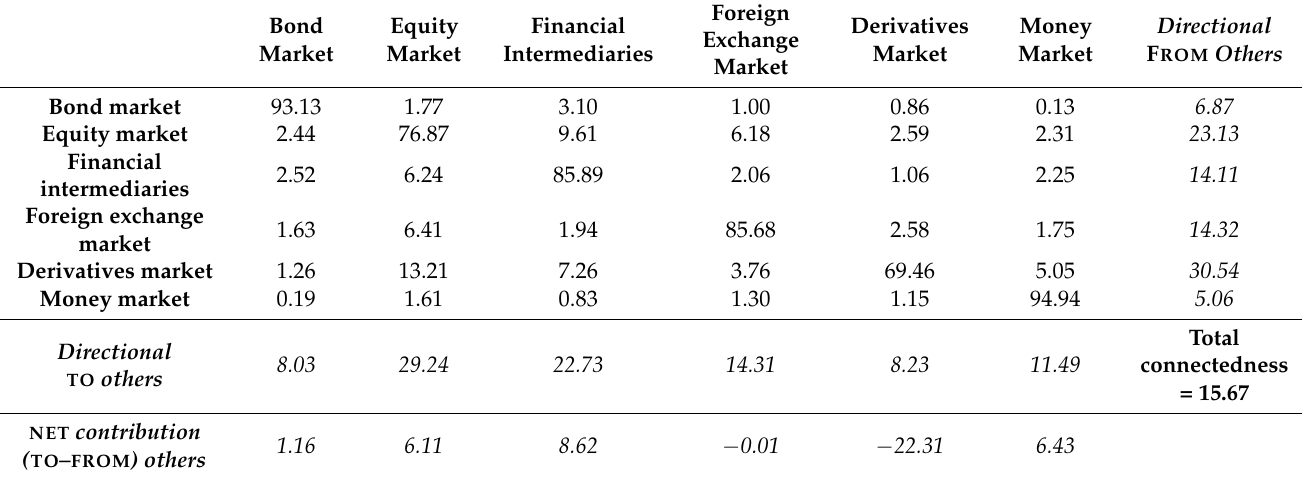
Table 3. Full-sample